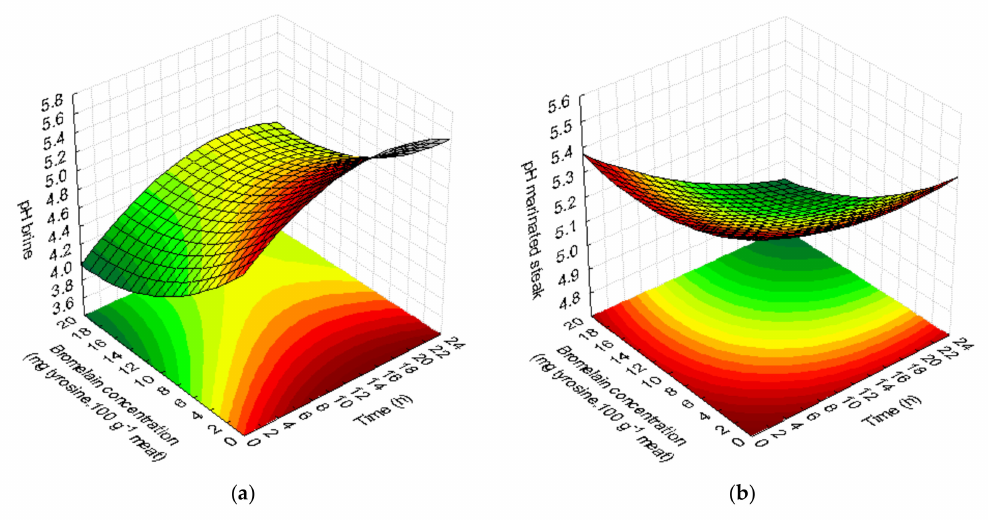
Figure 1. E ff ect of marinades on pH as a function of bromelain concentration (mg tyrosine.100 g − 1 meat) and time (h). Response surfaces fitted to pH of brine ( a ) and pH of marinated steak ( b